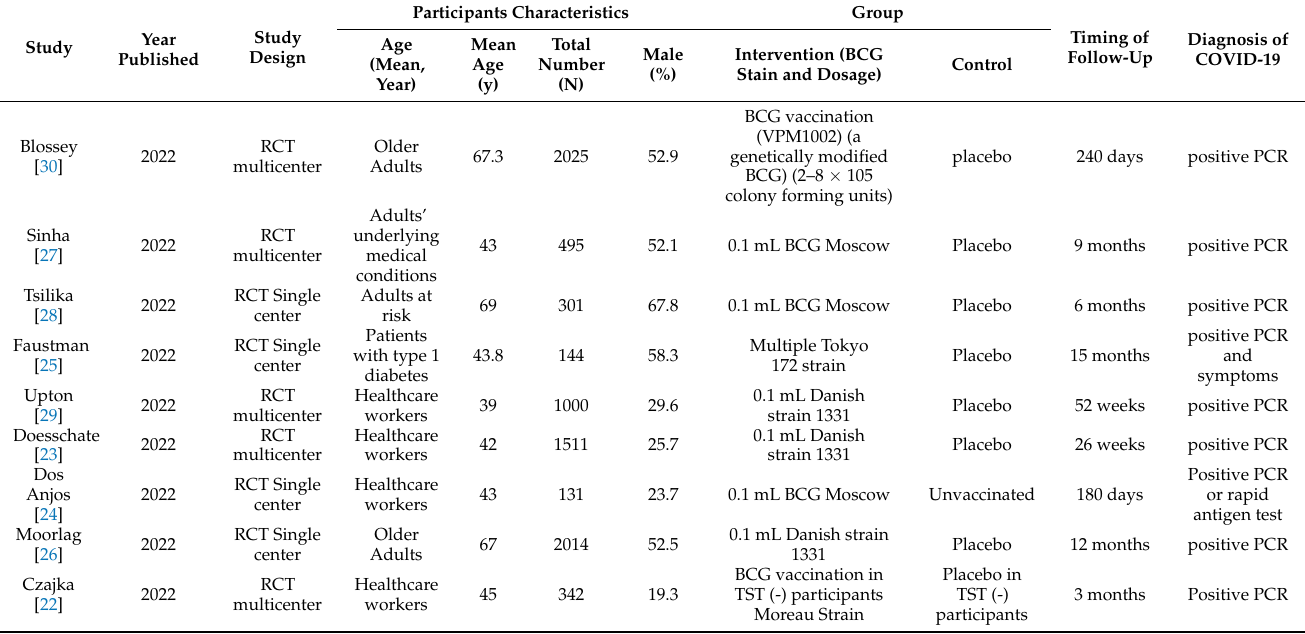
Table 1. Study characteristics and participant